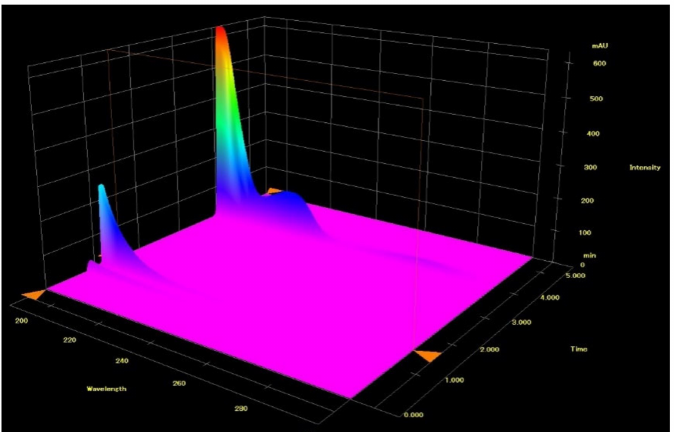
Figure 2. Full 3-D chromatogram of LiChrospher 125 × 4 mm column in acetonitrile and from the upper figure, got with 20% ACN and 80% 13 mM NH 4 H 2 PO 4 . The first meldonium peak eluted at retention time about 1.25 min, which showed poor UV-abs spectrum exponentially falling in value as the wavelength increased from 190 nm to about 230–235 nm, while meldonium shows intense three max Abs